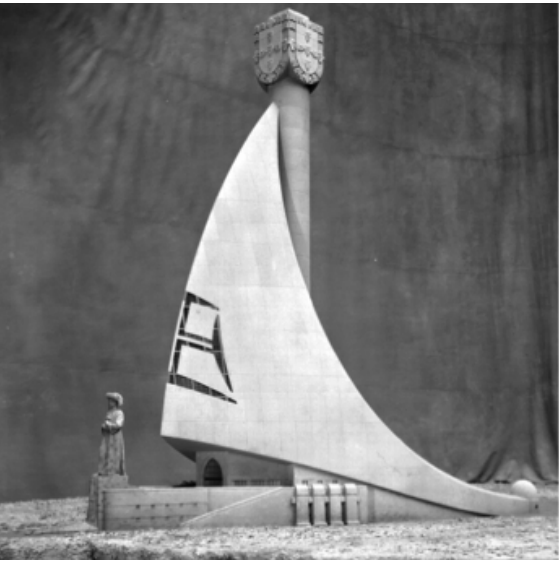
FIGURE 5 | C. Ramos, L. Almeida, A. Negreiros, Project, 1936, of serving as a mast of a caravel moving overseas, which was at the same time a chapel whose naviga- tion intended to symbolize the overseas expansion